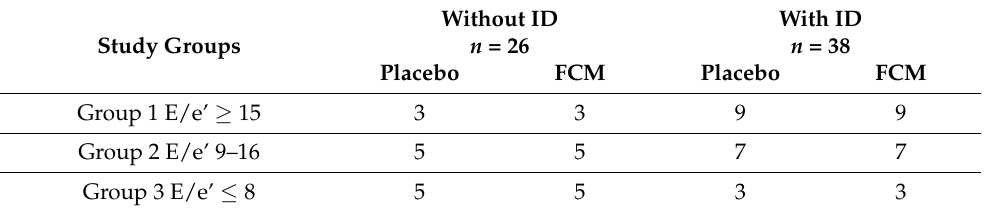
Table 1. Distribution of 64 patients entering the study among the different study